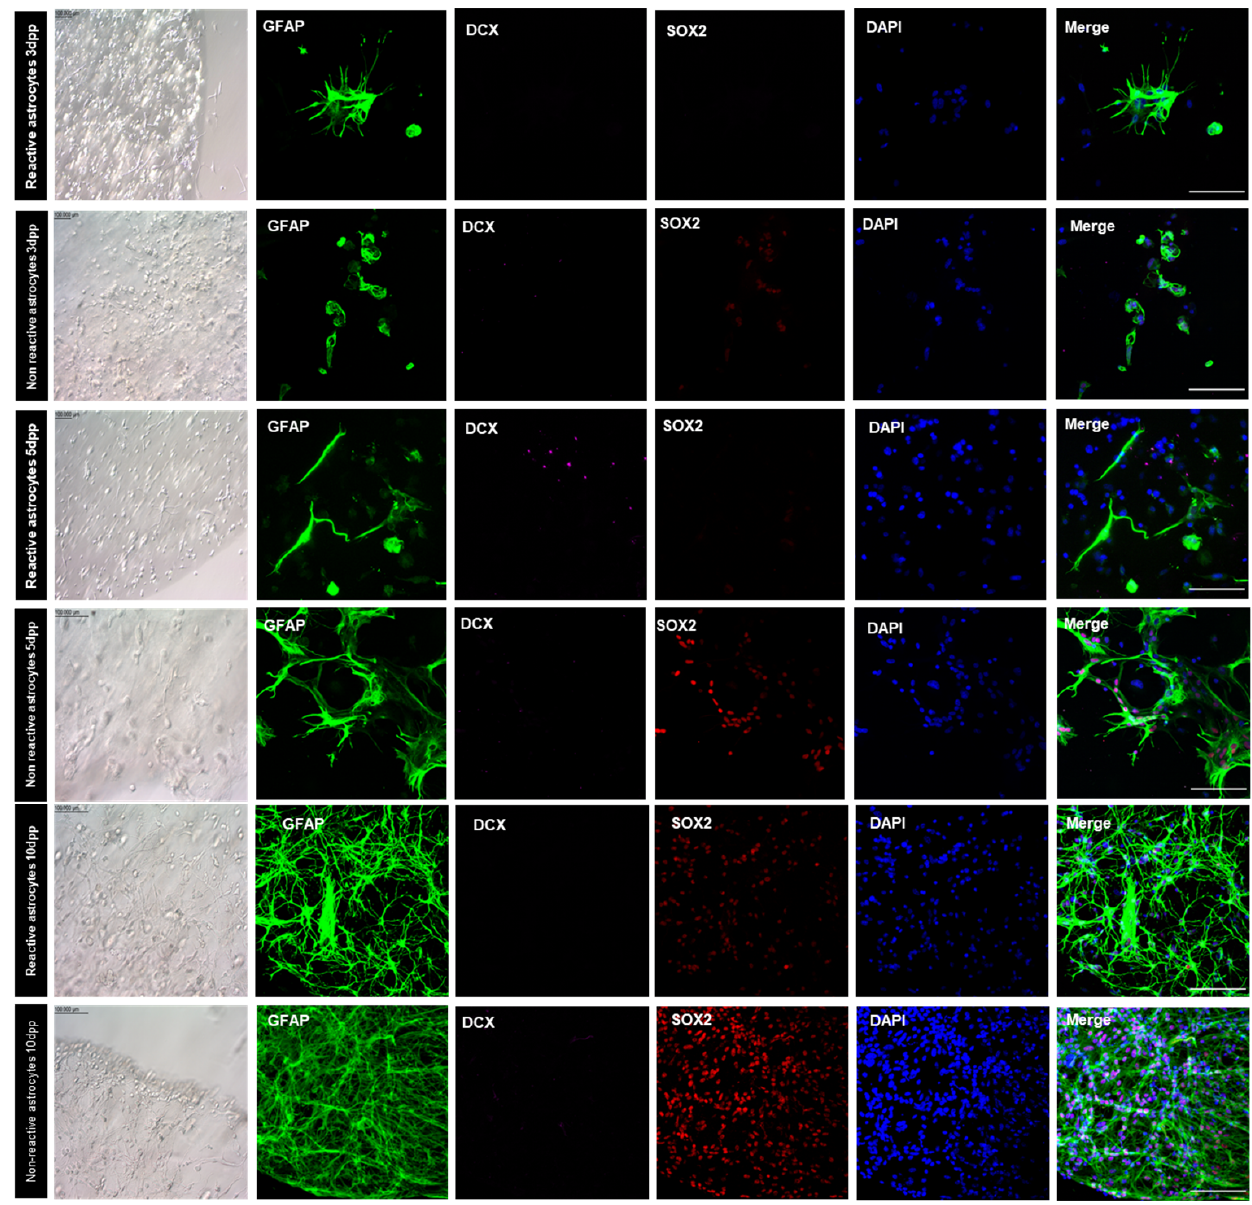
Figure 7. Immunofluorescence analysis of GFAP-, SOX2-, DCX-positive cells in bioprinted murine reactive and non-reactive astrocytes under influence of NSC culture media. While SOX2-positive nuclei were only observed in 3D-bioprinted reactive astrocytes at 10 dpp, this was noted at all timepoints for non-reactive astrocytes. In this group, cells formed a net throughout all constructs, as the majority of DAPI-stained nuclei were SOX2 positive. Scale bar (bright-field) = 100 µ m. Scale bar (fluorescence) = 50 µ m. dpp = days